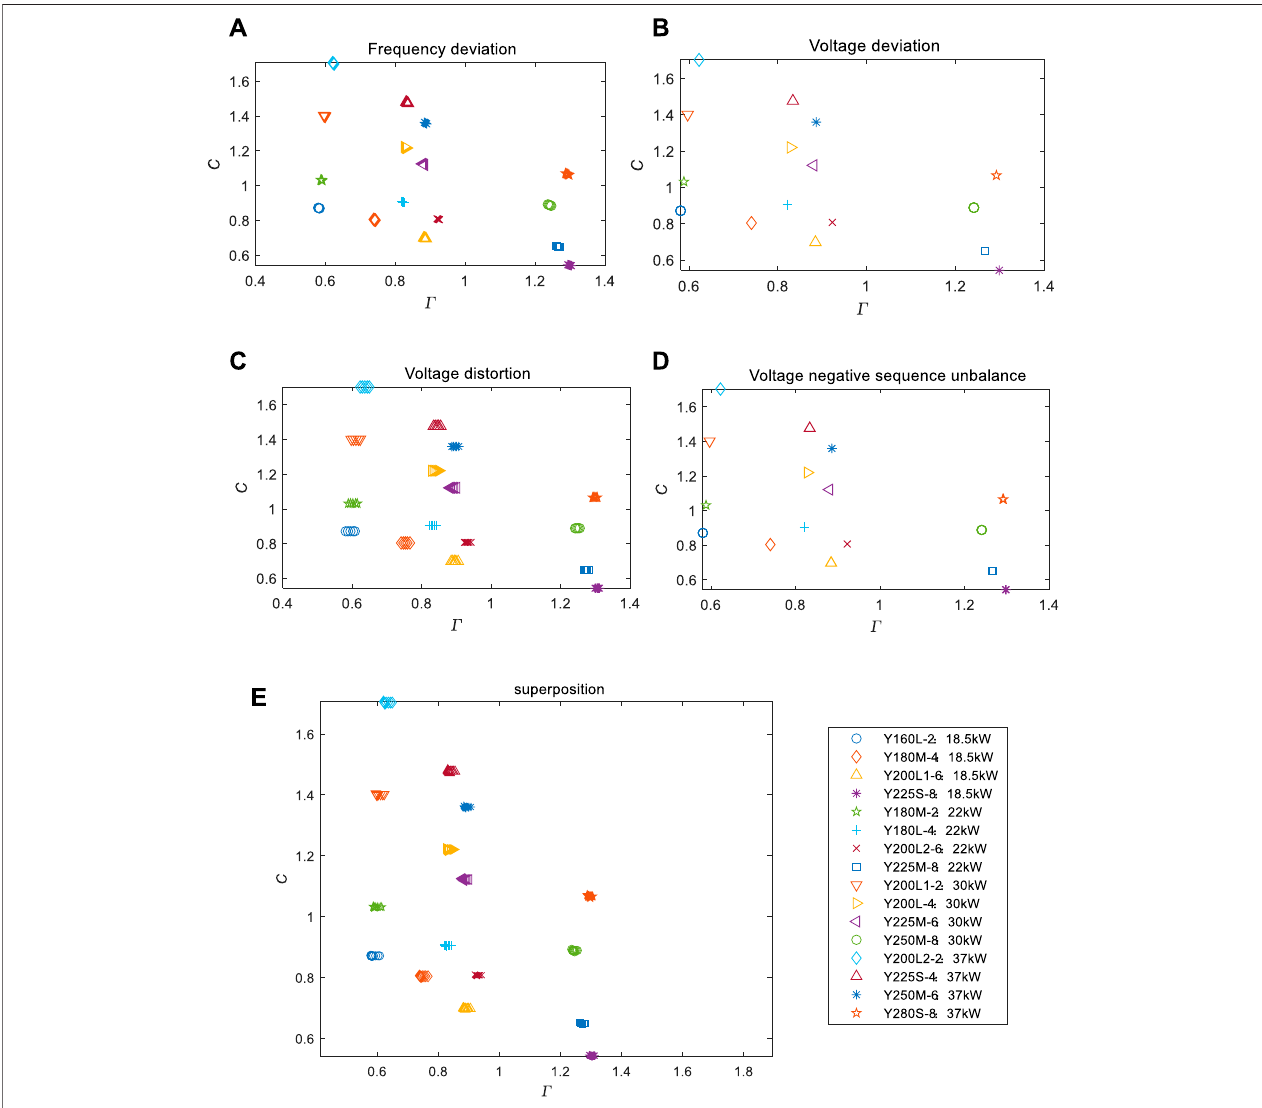
FIGURE 7 | Feature cluster distribution of induction motors under different power quality disturbances. (A) Feature distribution of each motor under different frequency deviation. (B) Feature distribution of each motor under different voltage deviation. (C) Feature distribution of each motor under different voltage distortion. (D) Feature distribution of each motor under different voltage negative sequence unbalance. (E) Summary and superposition of (A-D) .